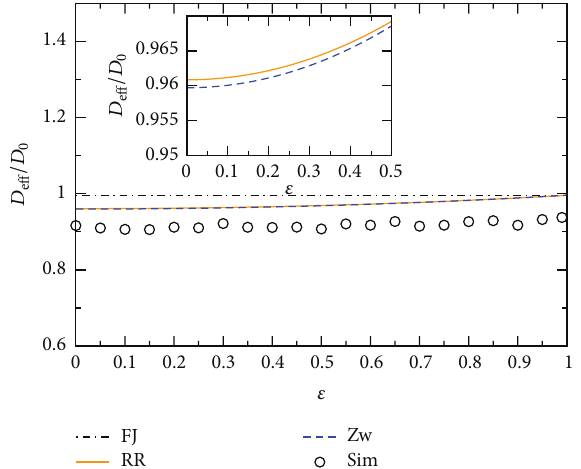
Figure 6: 𝐷 eff for the system in Figure 2, from (52), black dash and dot line, (54), blue dashed line, and (57), orange continuous line, as a function of the eccentricity 𝜀 of each link in the periodic elliptic tube (given 𝑅 = 1, 𝑎 = 0 . 9), compared with Data from computer simulations